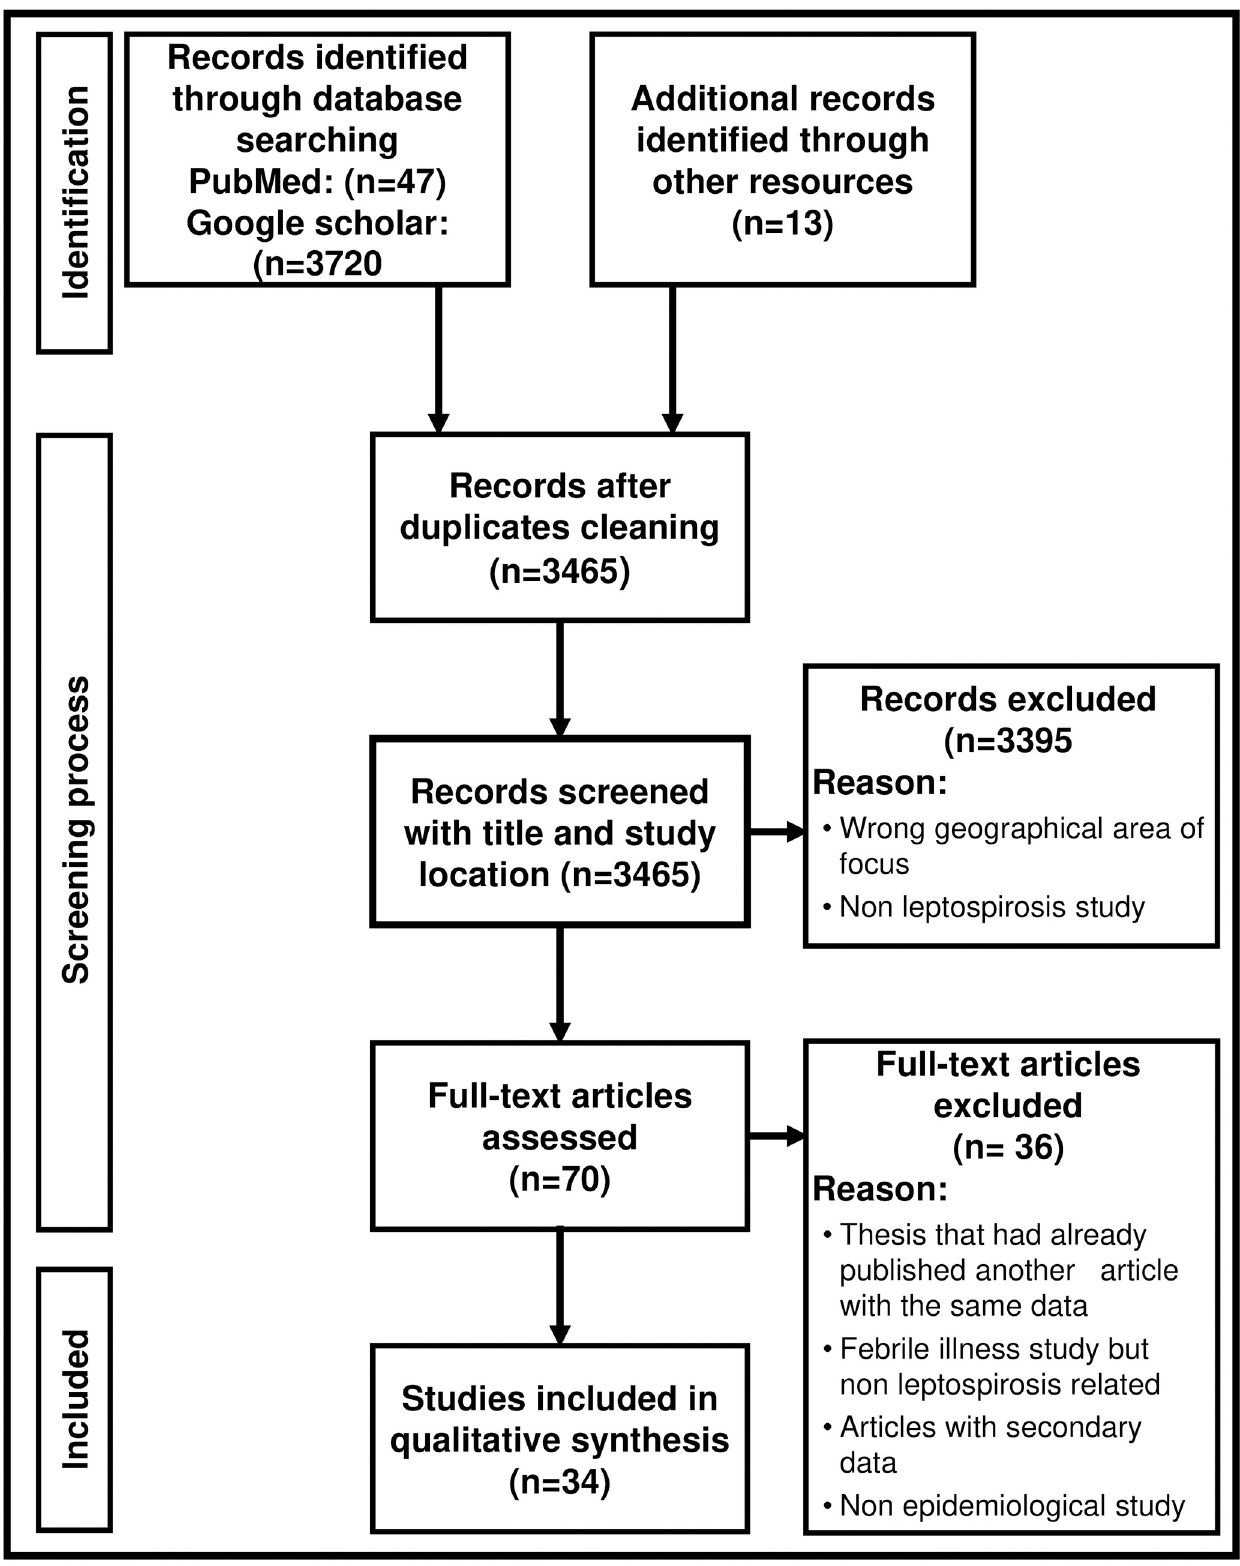
Fig 1. Flow diagram indicating how articles were included in the review regarding leptospirosis in Tanzania.